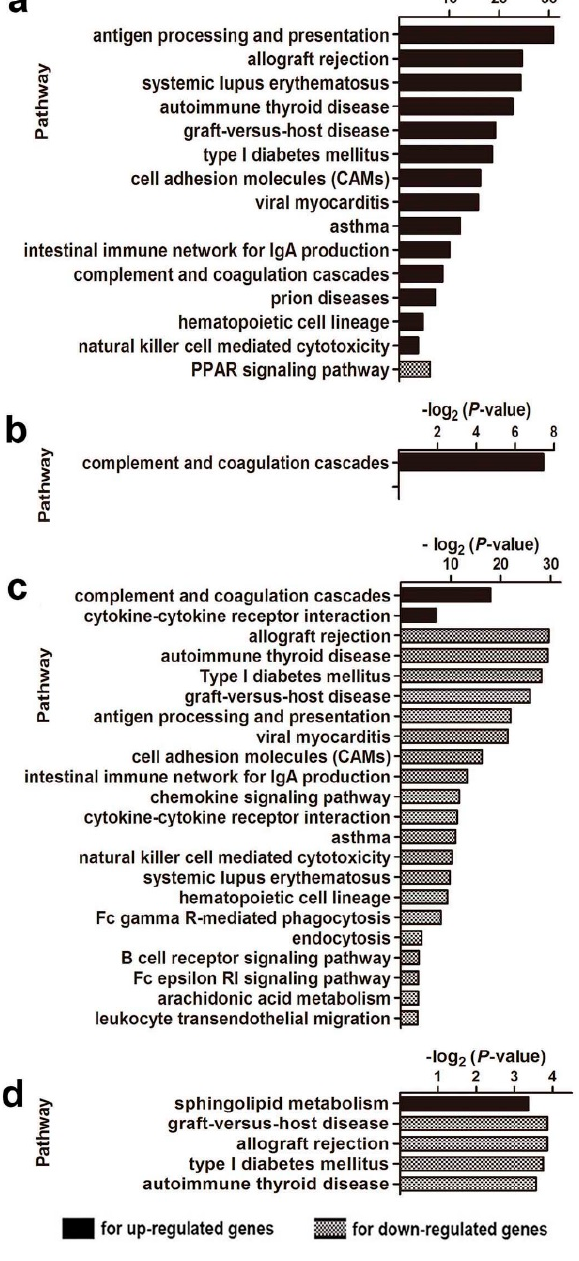
Figure 2. KEGG pathway analysis of DEGs: ( a ) based on the DEGs between CpG ODN and control ODN-treated WT mice; ( b ) based on the DEGs between CpG ODN and control ODN-treated NOD mice; ( c ) based on the DEGs between CpG ODN-treated WT and NOD mice; and ( d ) based on the DEGs between Control ODN-treated WT and NOD mice.